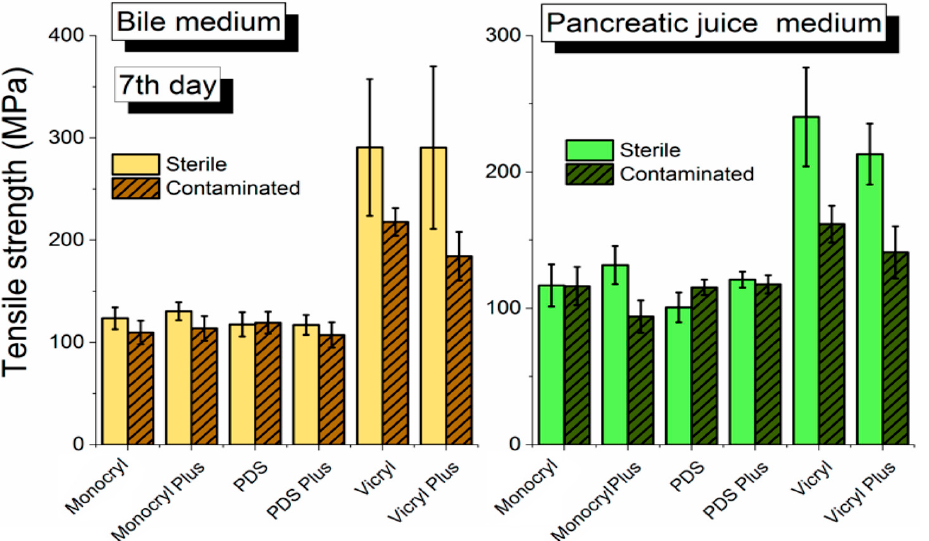
Figure 3. Comparison of the tensile strength of surgical sutures examined in sterile and contaminated bile at day 7 of the experiment.